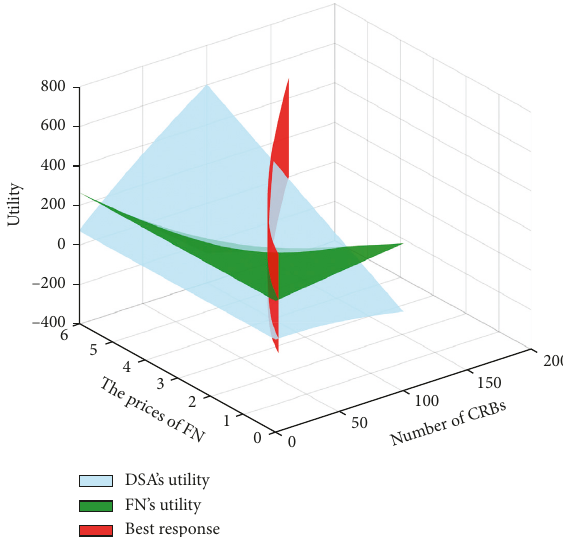
Figure 7: The relationship between price, CRB quantity and